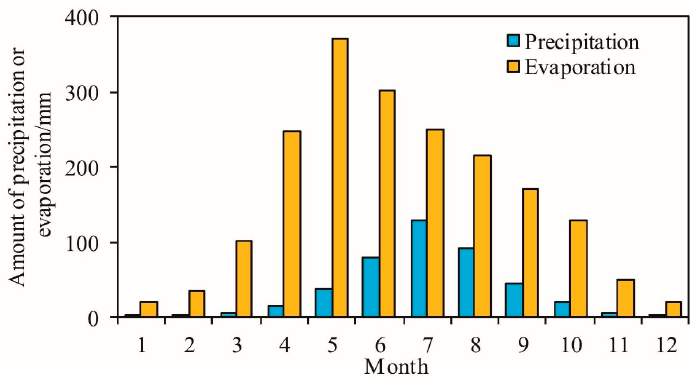
Figure 2. Monthly mean value of precipitation and evaporation in the study area from 1951 to 2017.